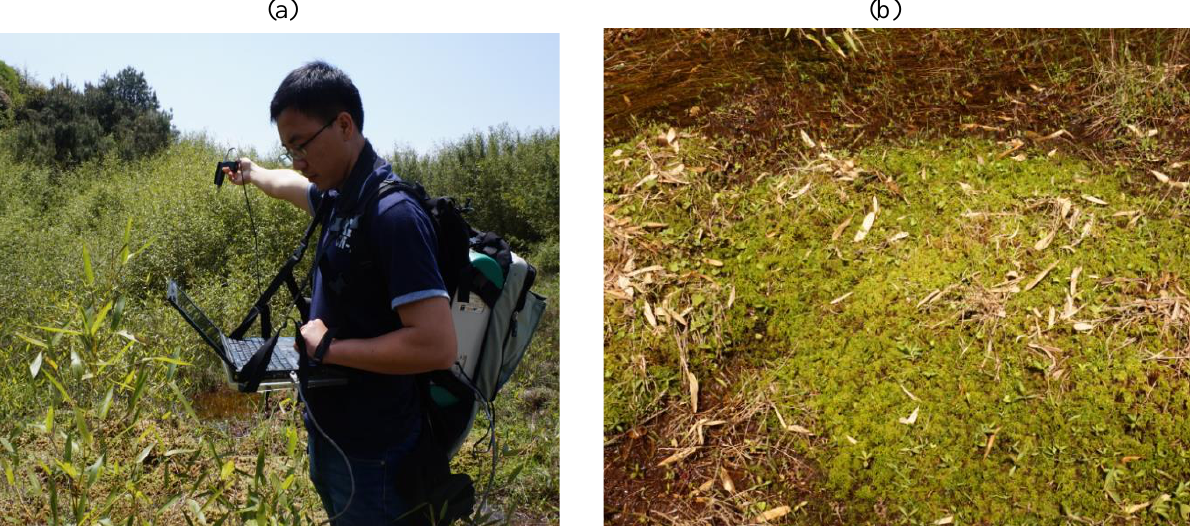
Figure 4. (a) Field spectroscopy (ASD FieldSpec3) setup for spectral characterisation of the vegetation at Plot 1 ( P. heteroclada and S. magellanicum community); (b) S. magellanicum at Plot 2.